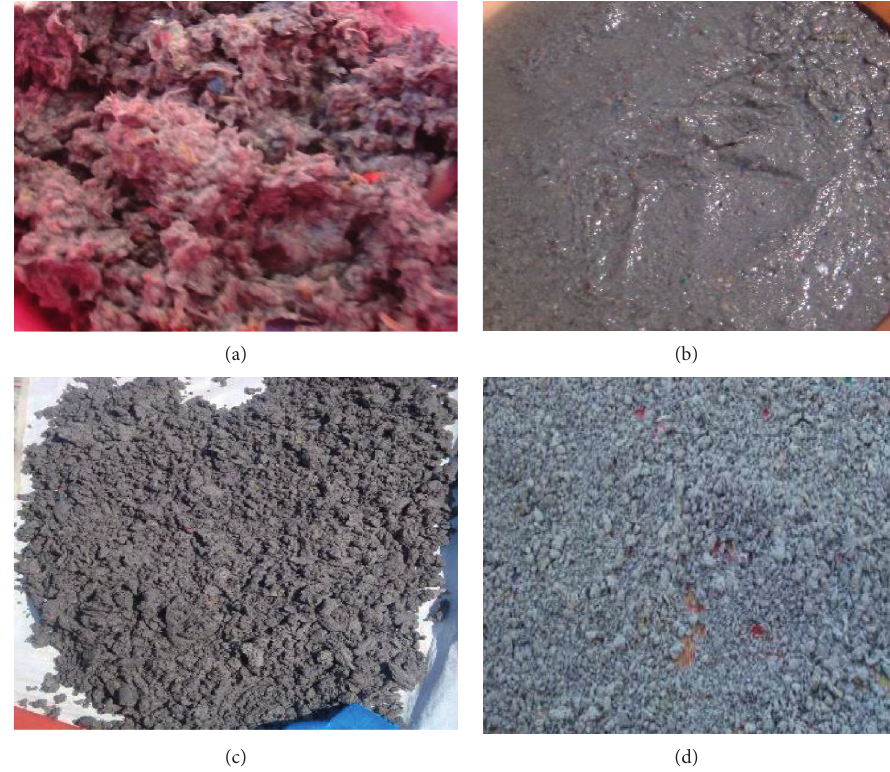
Figure 1: Preprocessing process of paper waste. (a) Wet mass. (b) After grinding. (c) During sun drying. (d) Final mass.